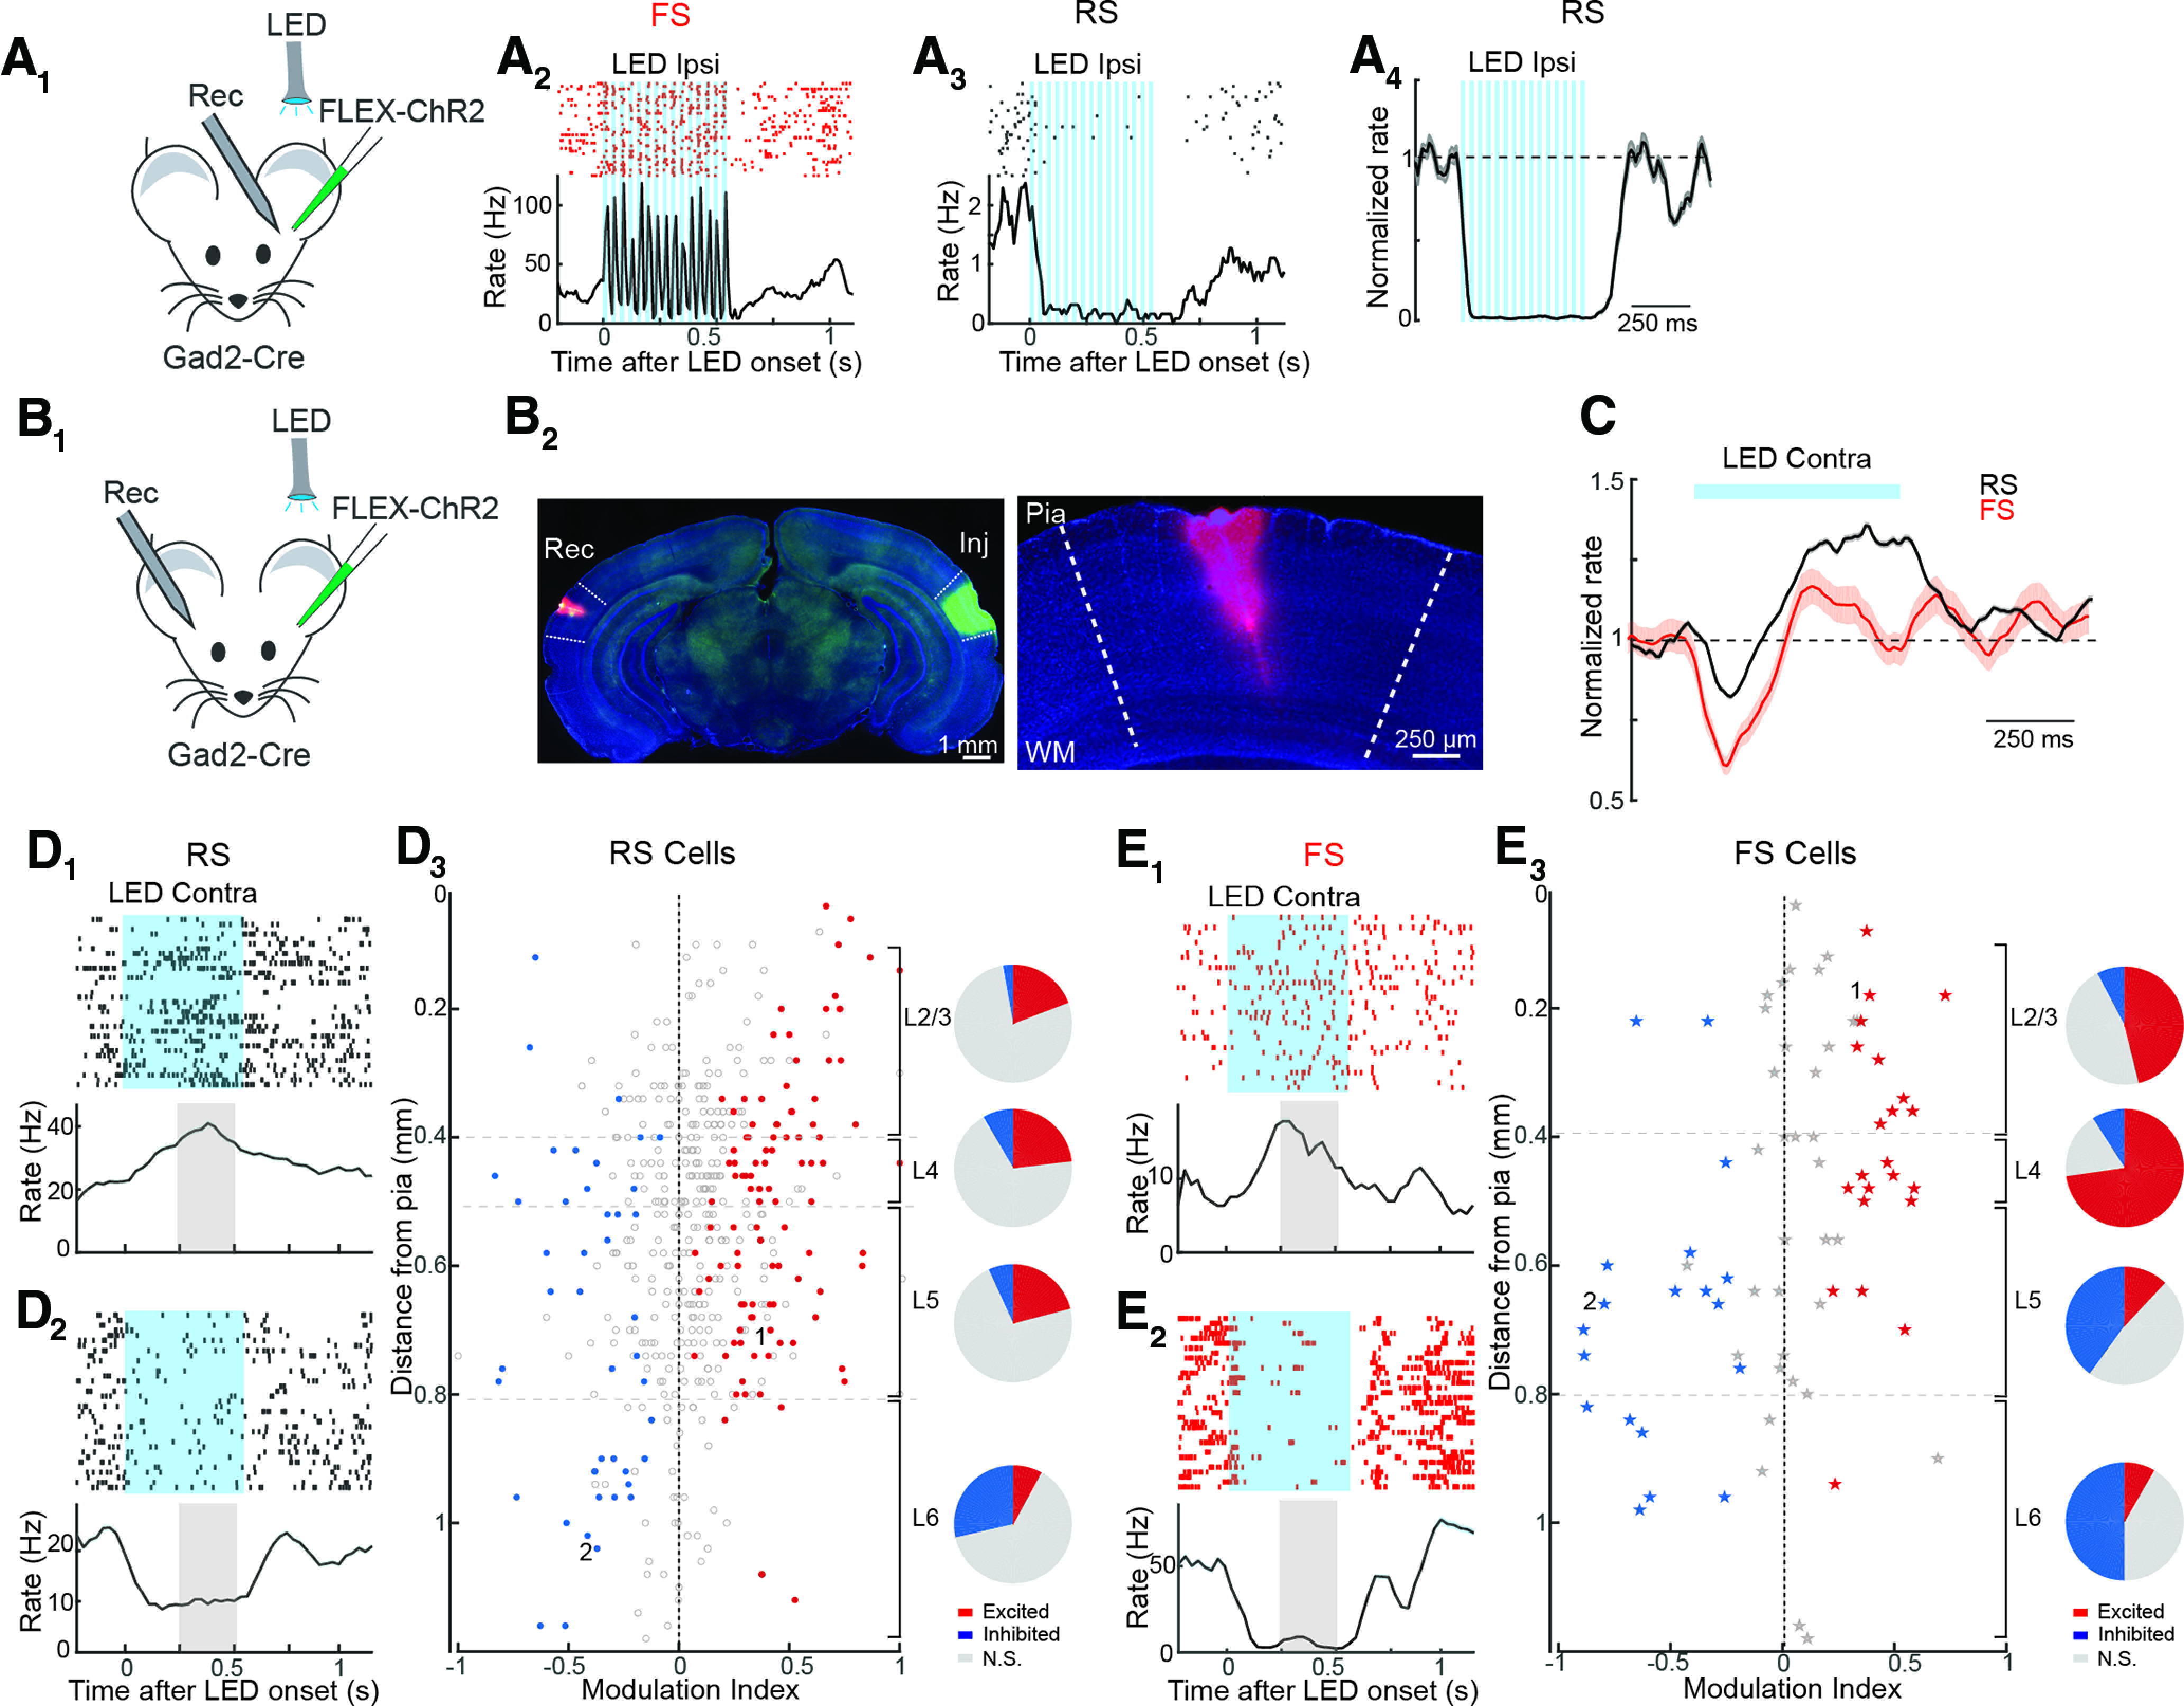
Acute optogenetic silencing of interhemispheric cortical input causes a sustained increase in spontaneous activity in most layers of A1. A, Local activation of ChR2-expressing interneurons silences RS cell activity. A1, Recording configuration. A2, Spike raster (top) and peristimulus time histogram (PSTH; bottom) show strong activation of a representative FS unit by an ipsilateral LED pulse train (blue bars). A3, Spike raster (top) and PSTH (bottom) show strong suppression of simultaneously recorded RS unit. A4, Summary of ipsilateral LED-evoked suppression of RS activity (n = 34 units, 2 mice). B, Activation of ChR2-expressing interneurons in one hemisphere leads to transient inhibition followed by excitation in contralateral A1. B1, Recording configuration. B2, left, Coronal section showing ChR2 expression (green) within A1 of the injected left hemisphere (Inj) and DiI-labeled recording electrode tract (red) in contralateral A1 (Rec). Right, Blow-up of recording site. WM = white matter. C, Average normalized PSTH of RS (black) and FS (red) units shows that sustained LED illumination (bar) drives transient decrease and sustained increase in firing. Shading, ±SEM D, Inactivation of A1 causes sustained increase in activity of RS units in layers 1–5 of contralateral A1. D1, Individual L5 RS unit spike raster and PSTH showing that silencing contralateral A1 (blue shading) enhances firing. Gray shading indicates measurement period used to calculate modulation index. D2, L6 RS unit with sustained suppression during silencing of contralateral A1. D3, left, Modulation index of units significantly activated (red) or inhibited (blue) across all layers. Open circles indicate units without significant effect and cells marked 1 and 2 represent units in D1, D2, respectively. Right, Pie charts indicate proportion of units excited (red), inhibited (blue), or not significantly modulated (gray) in each layer. E, Silencing contralateral A1 causes a rapid and sustained decrease in firing in deep layer FS cells, as well as a sustained firing increase in upper layer FS cells. Representative L2/3 and L5 FS unit are plotted in E1, E2, respectively. E3, Modulation index of FS units across all cell layers are illustrated as in D3.